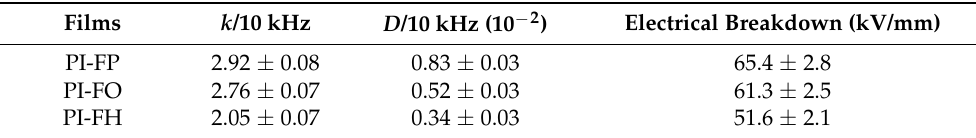
Figure 7. The dependence of the dielectric properties on frequency for PI films at room temperature. Table 4. The dielectric parameters of PI